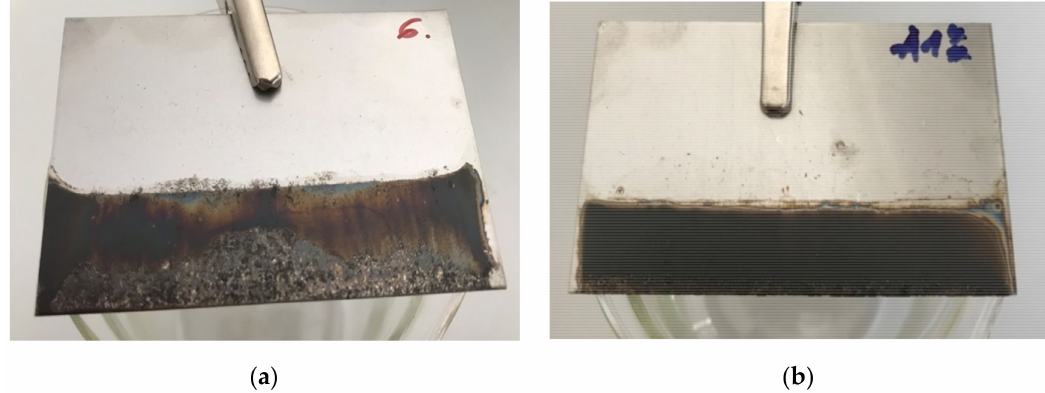
Figure 11. ( a ) First application of GO by EPD, ( b ) third application of GO by EPD. The deposition is thicker with the third application of the GO layers as it is shown in Figure 11b. The same conditions were used for all depositions. Obviously, the film deposited on both sides of the electrode that was submerged in the liquid. The outlines of GO sheets were visible (SEM micrographs, Figure 12). The structure of GO was highly wrinkled. The void spaces that were visible with one deposition (Figure 12a) disappeared with three depositions of GO and the thicker and more homogeneous surface was observed (Figure 12b). The results of the scanning electron microscopy (SEM) and energy dispersive X-ray detector (EDX) analyses of the GO deposited on SS with the elemental mapping are given in Figure 13a,b. These results are in good agreement with the results of the TEM analysis.